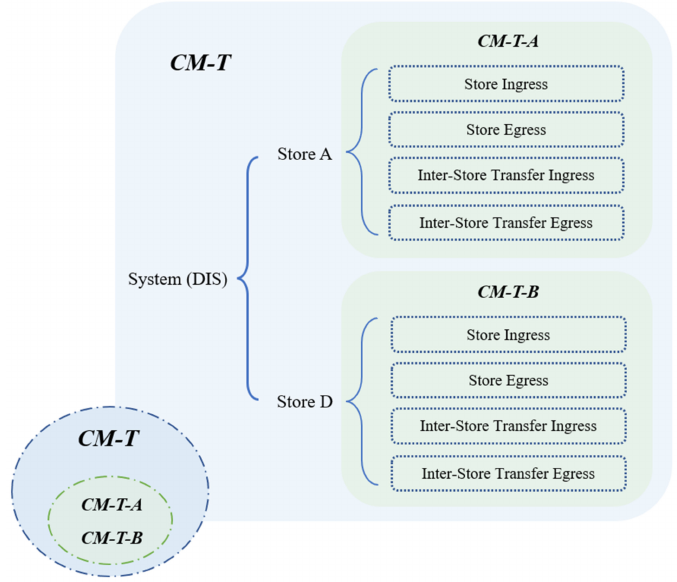
Figure 18. Conceptual Model—Tactical plane CM-T (blue) and sub-planes CM-T-A & CM-T-B (green). The round inset is meant to show that CM-T contains both CM-T-A and